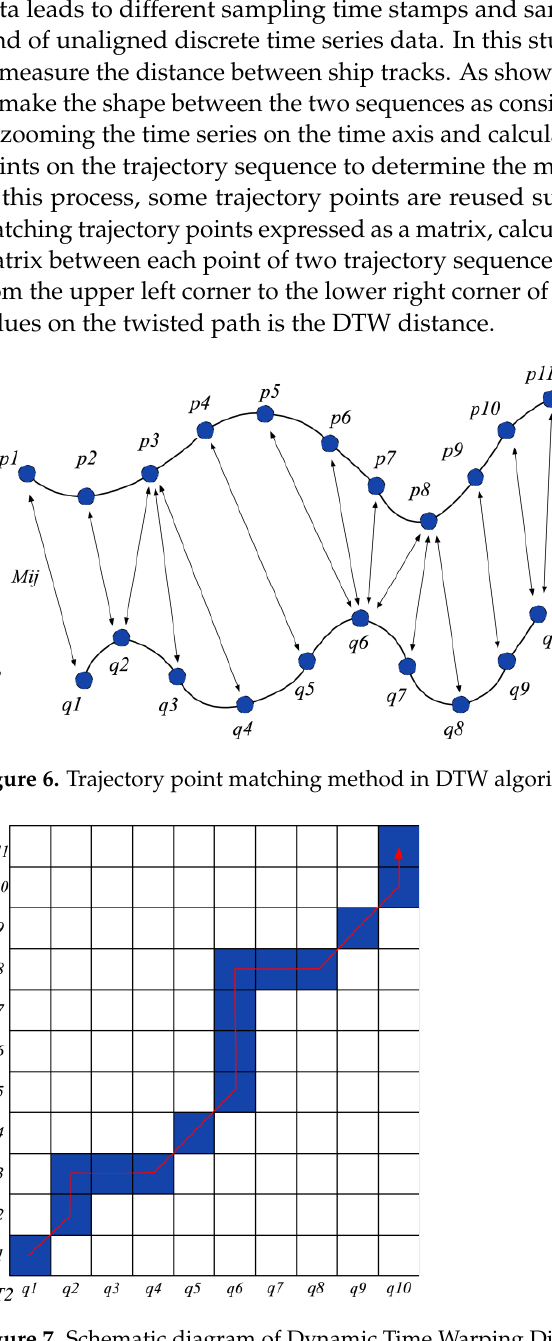
Figure 7. Schematic diagram of Dynamic Time Warping Distance.